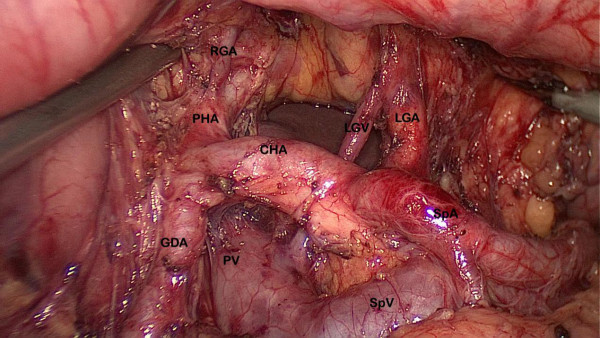
Dissection of the lymph node numbers 7, 8, 9, 11p and 12a. CHA: common hepatic artery; GDA: gastroduodenal artery; LGA: left gastric artery; LGV: left gastric vein; PHA: portal hepatic artery; PV: portal vein; SpA: splenic artery; SpV: splenic vein.